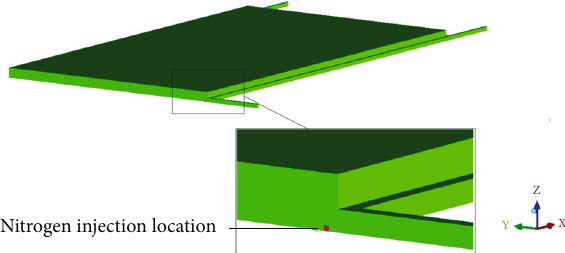
Figure 11: Location of nitrogen injection